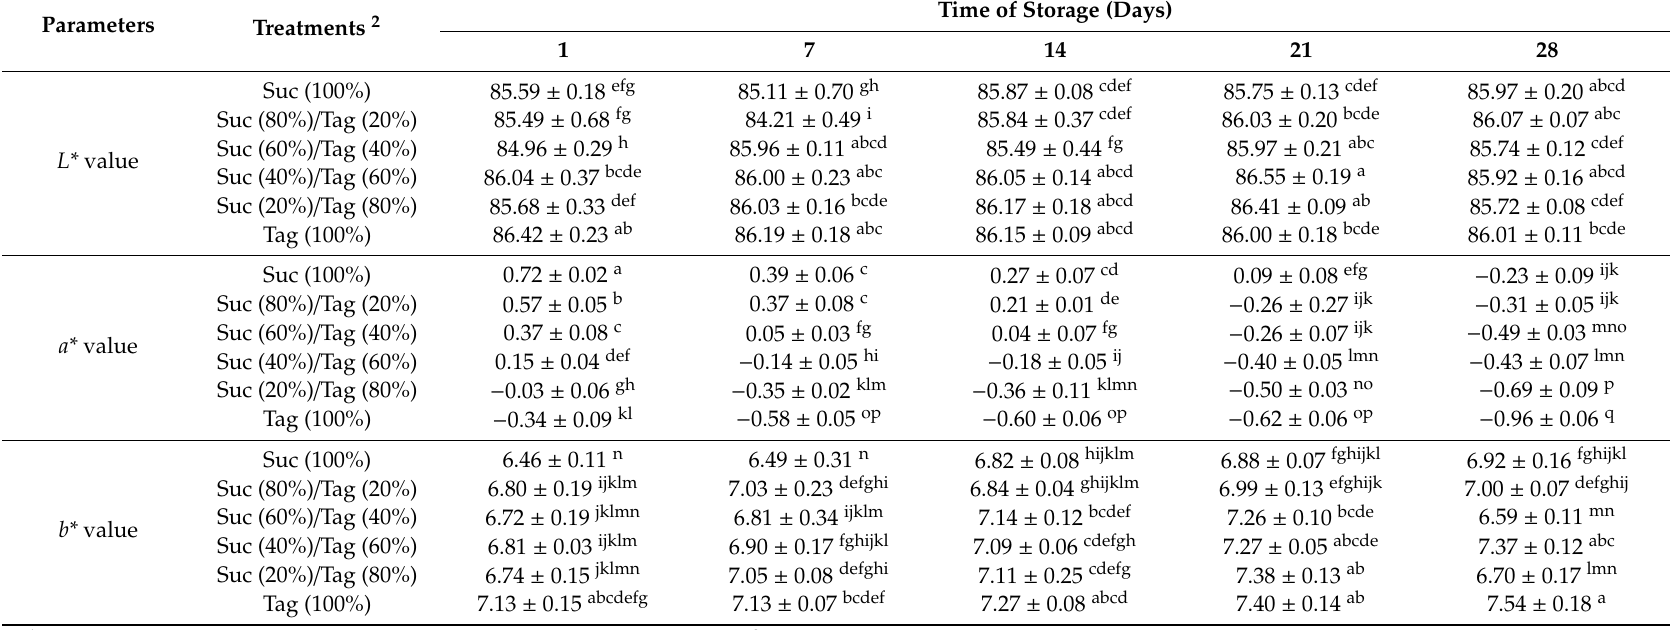
Table 3. E ff ects of tagatose substitutions on the color ( L* , a* , and b* ) values 1 of yogurts during 28 days of storage at 4 ◦